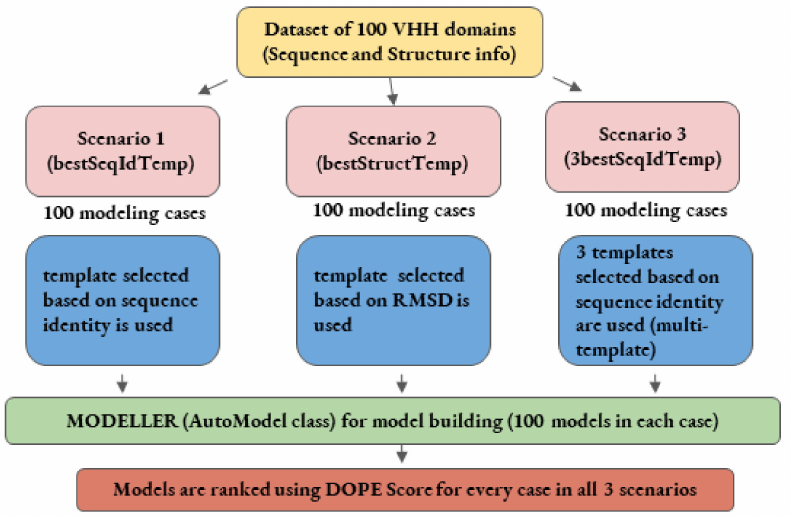
Figure 2. Schematic representation of comparative modeling workflow employed in the first three